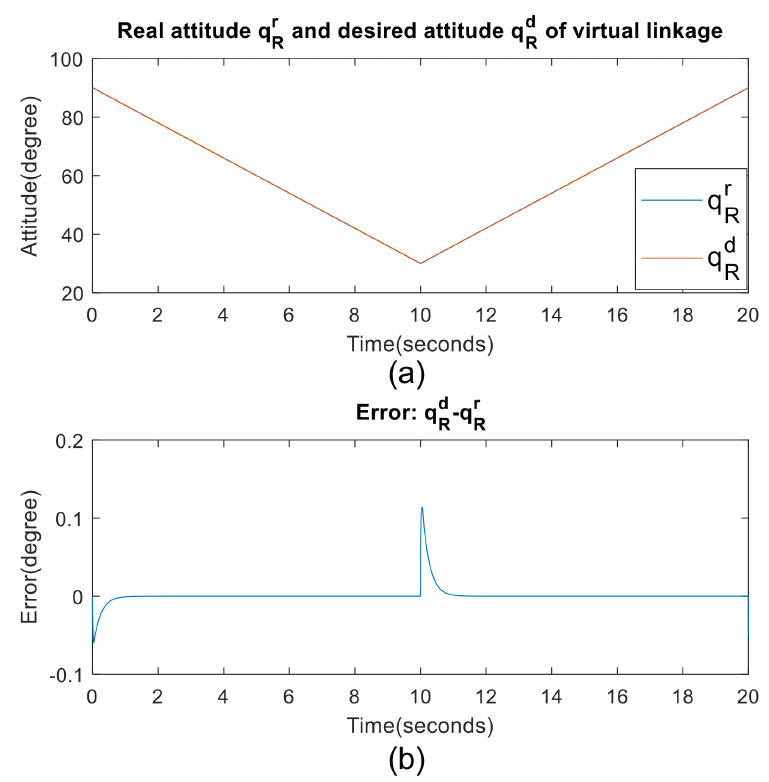
Figure 16. ( a ) Real and desired attitude of the virtual linkage; ( b ) error between real and desired attitude.